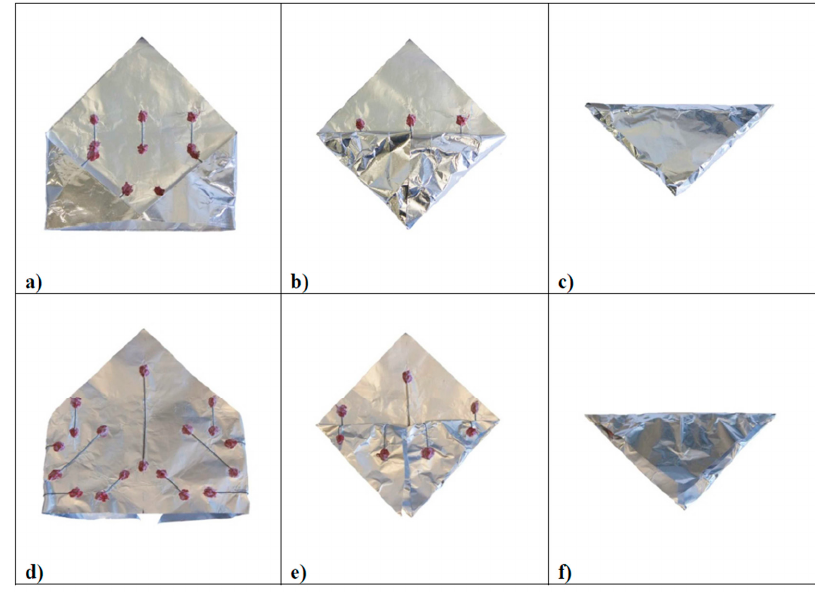
Figure 2. Step of folding in Configuration 2 ( a – c ) and Configuration 4 ( d – f ).